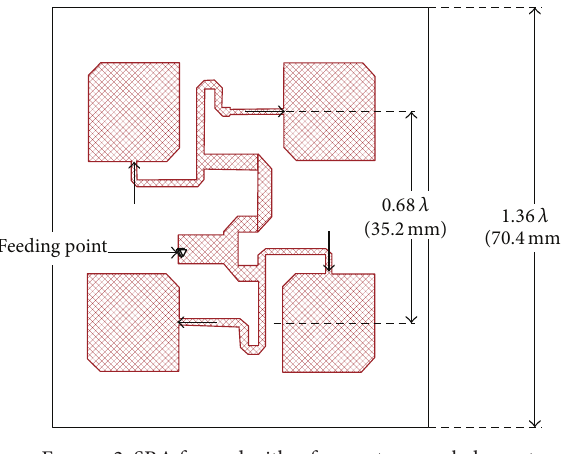
Figure 2: SRA formed with a four-antenna subelement.